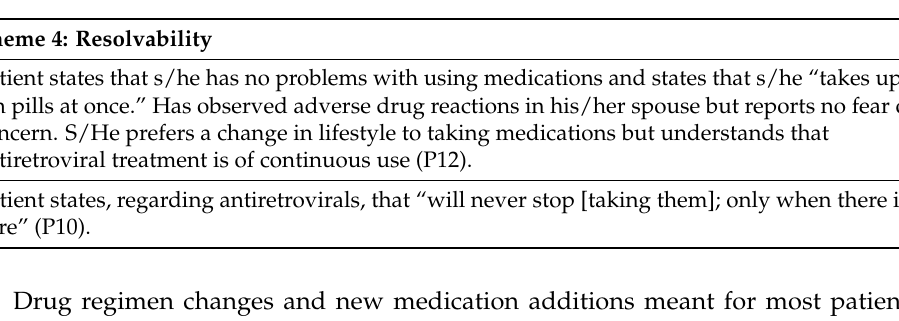
Table 5. Resolvability